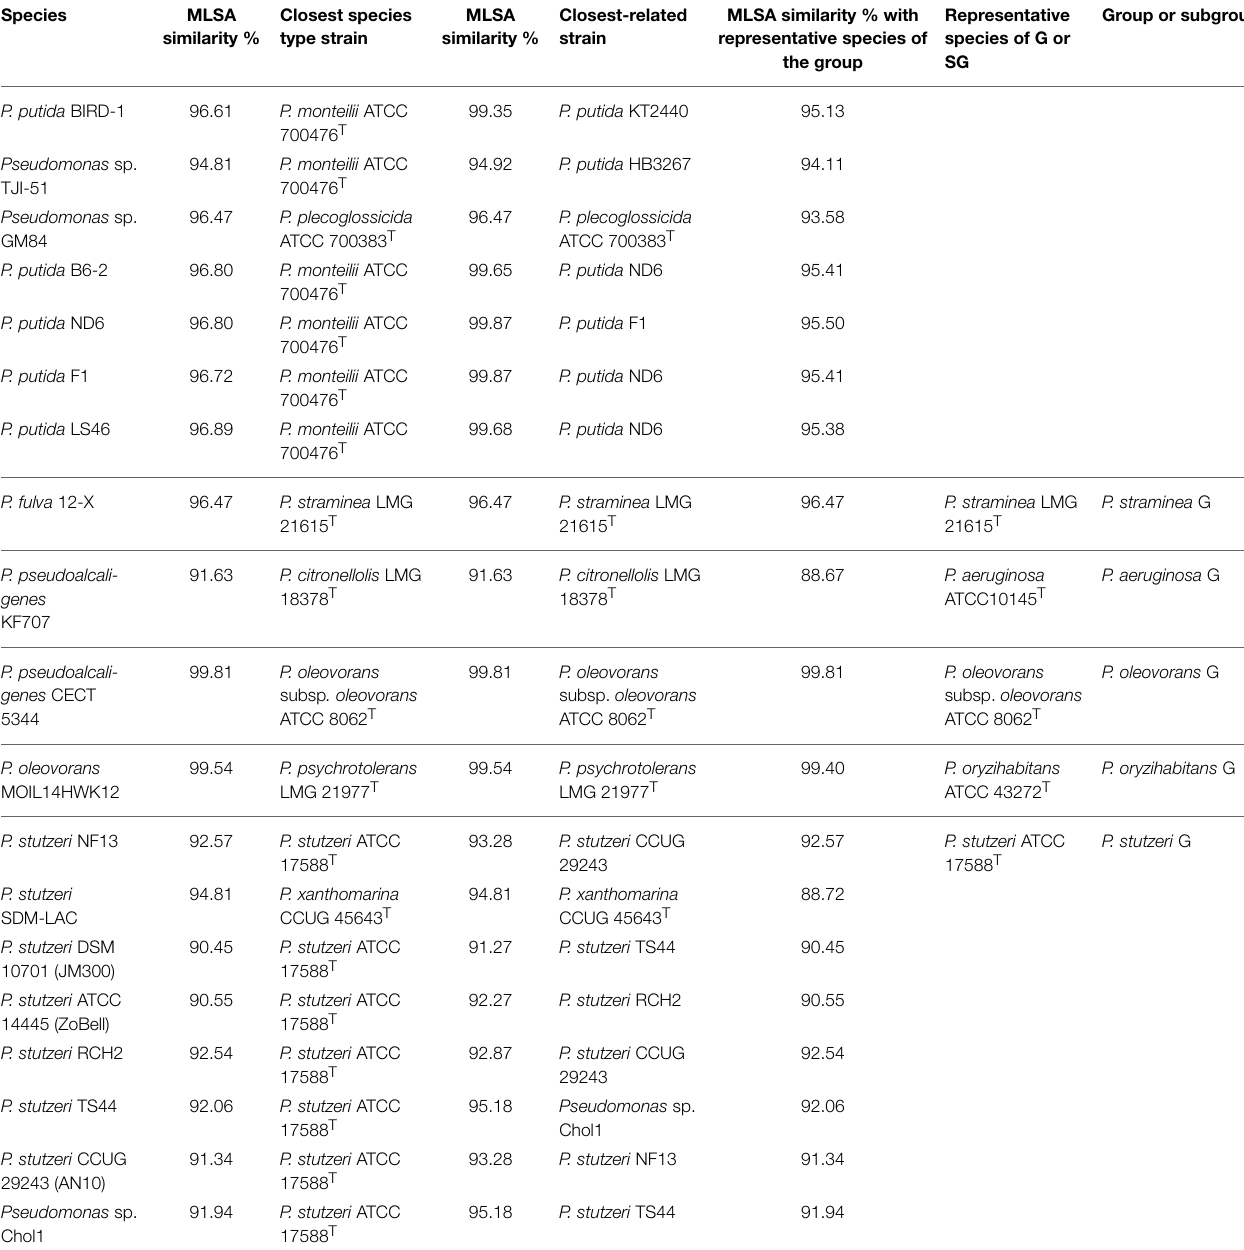
the whole-genome comparison results and concatenated phy- logenetic MLSA distances were also performed (Supplementary Table 3). Among the various methods proposed for substituting the experimental DDH high correlations were found between MLSA and ANIb (0.933 Spearman’s rho and 0.917 Pearson coef- ficients) and between MLSA and GGDC (0.928 Spearman’s rho and 0.766 Pearson’s coefficients). The Pearson’s correlation coef- ficients between ANIm and MLSA, GGDC and MLSA, and